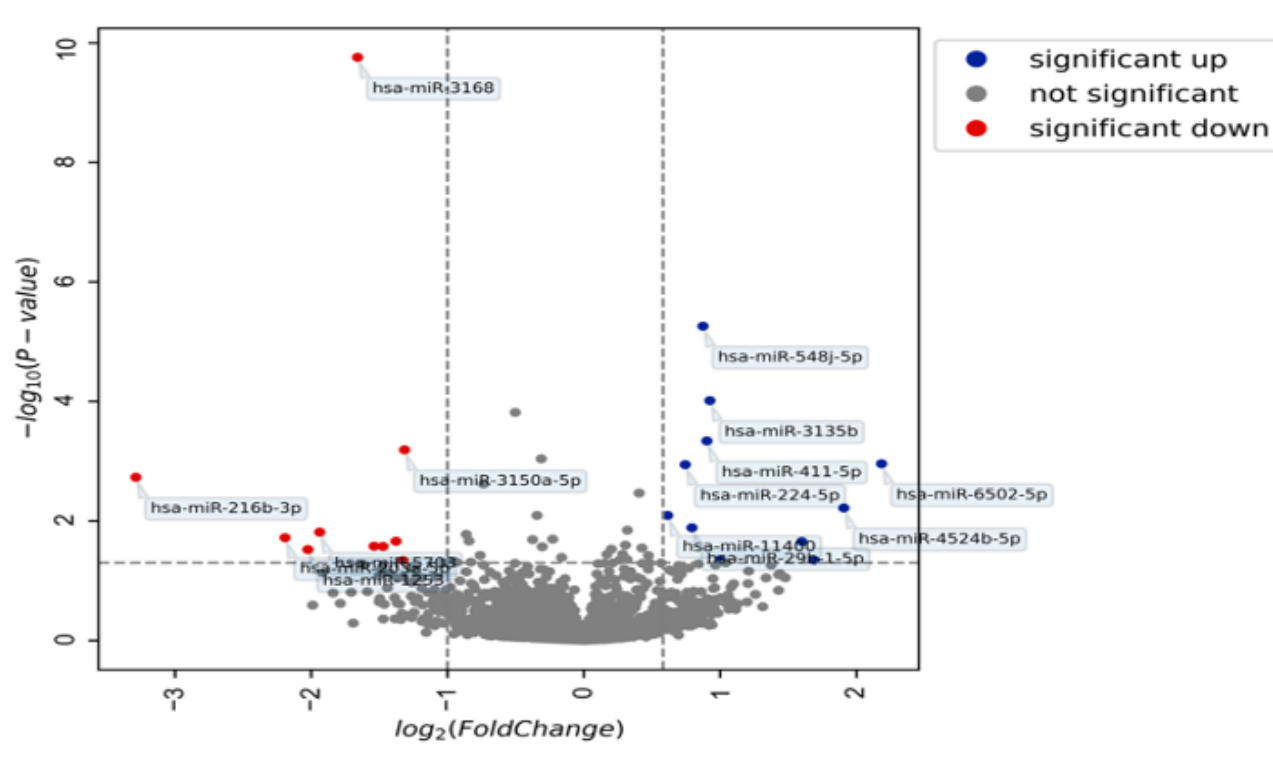
Figure 3. Volcano plot of expressed miRNAs in plasma for endometriosis.